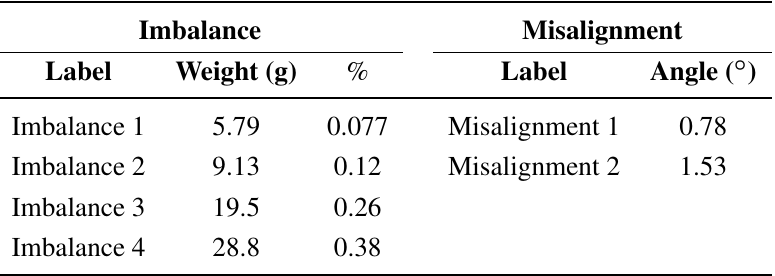
Table 1. Type and level of